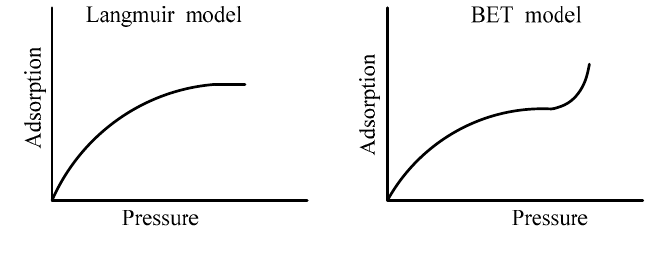
Figure 8. Two types of adsorption isotherms.